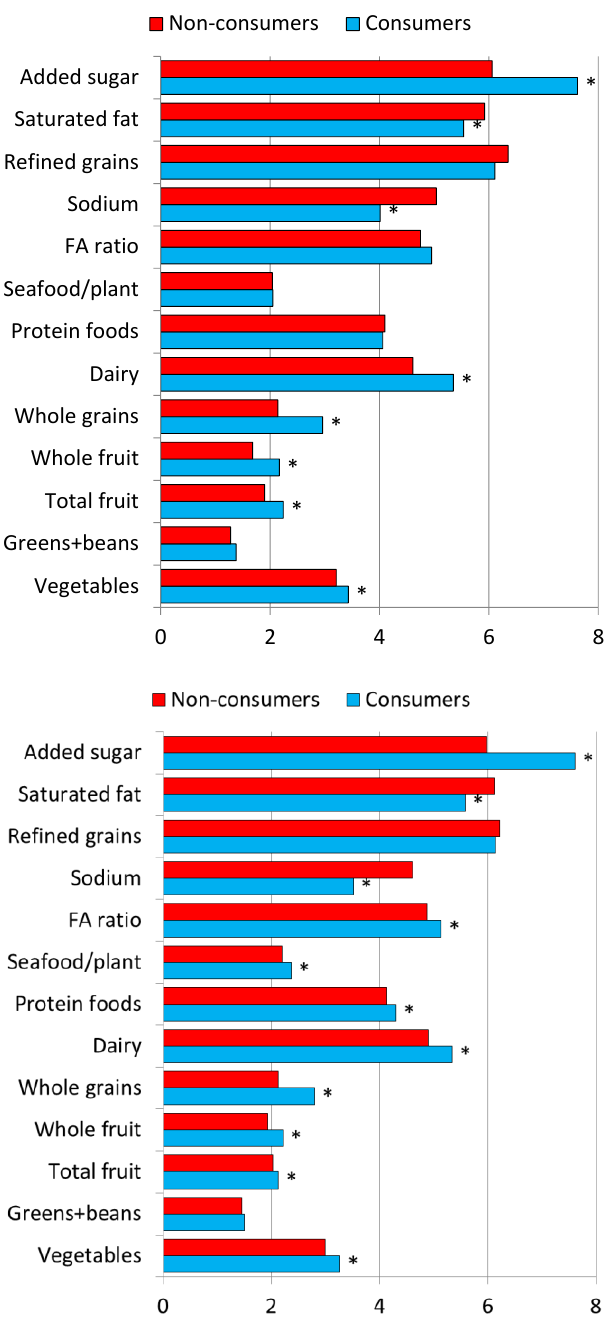
Figure 1. Comparing consumers and nonconsumers of LCS by HEI-2015 diet quality scores in 1988–1994 NHANES (top) and 1999–2018 NHANES (bottom). * Significantly different from nonconsumers, p < 0.05.